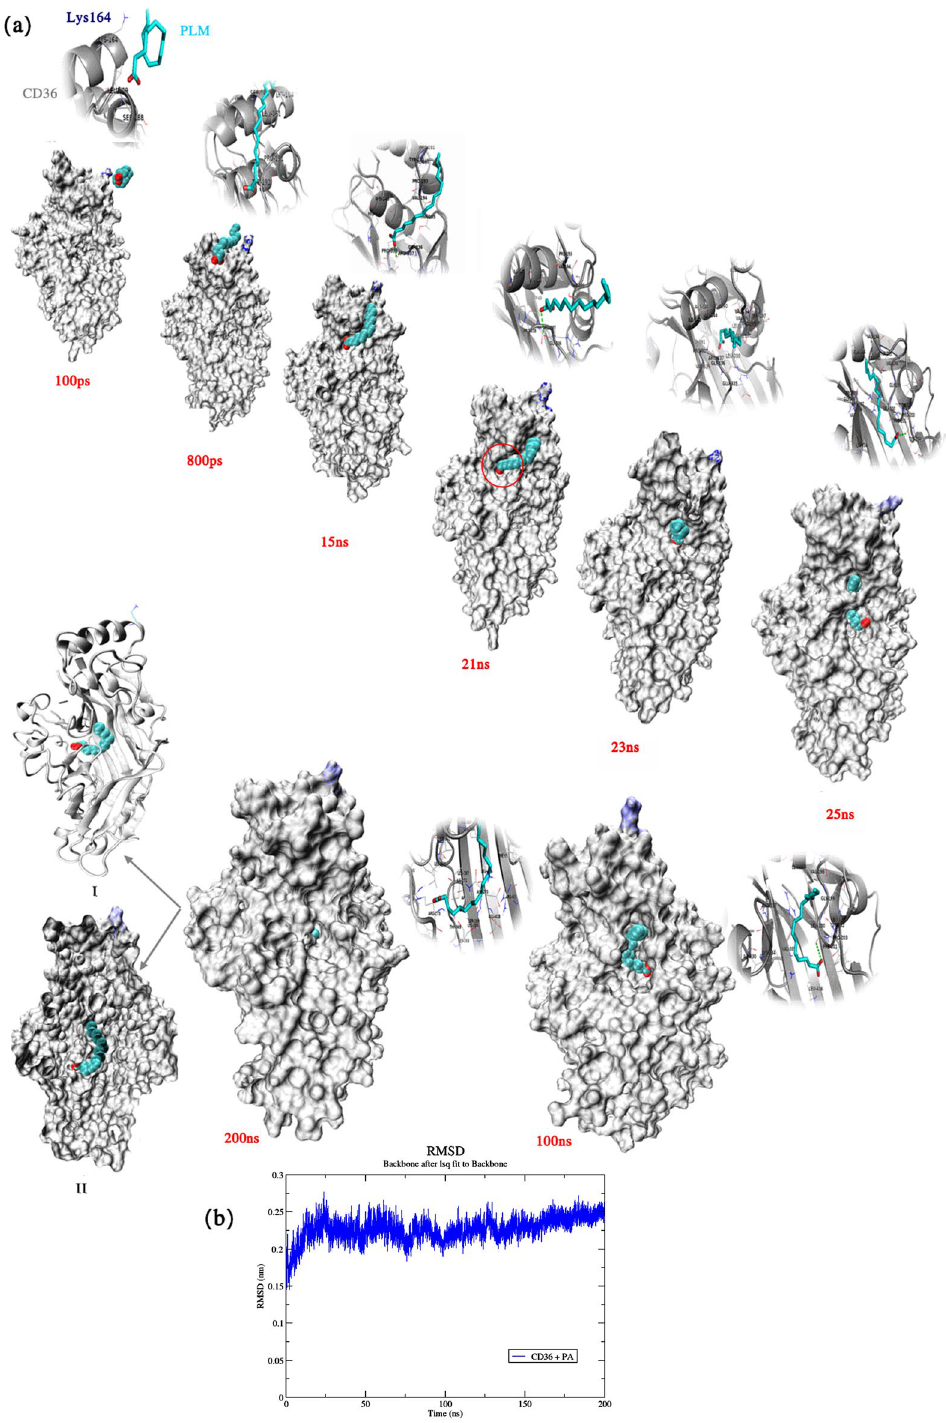
Figure 6. A snapshots representing the pathway of palmitic acid al transport at the portal of the CD36. ( a ) The snapshots correspond with 100 ps, 800 ps, 15 ns, 21 ns, 23 ns, 25 ns, 100 ns, 200 ns with one FA adsorbed to the protein. ( b ) The RMSD of the system, as they evolve with time. A is representation of Fatty acids at the starting point of the simulation 200